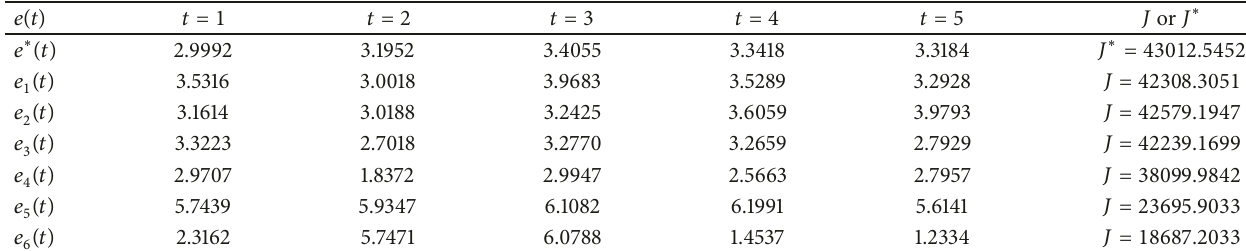
Table 3: Comparison of multi-cycle emission reduction